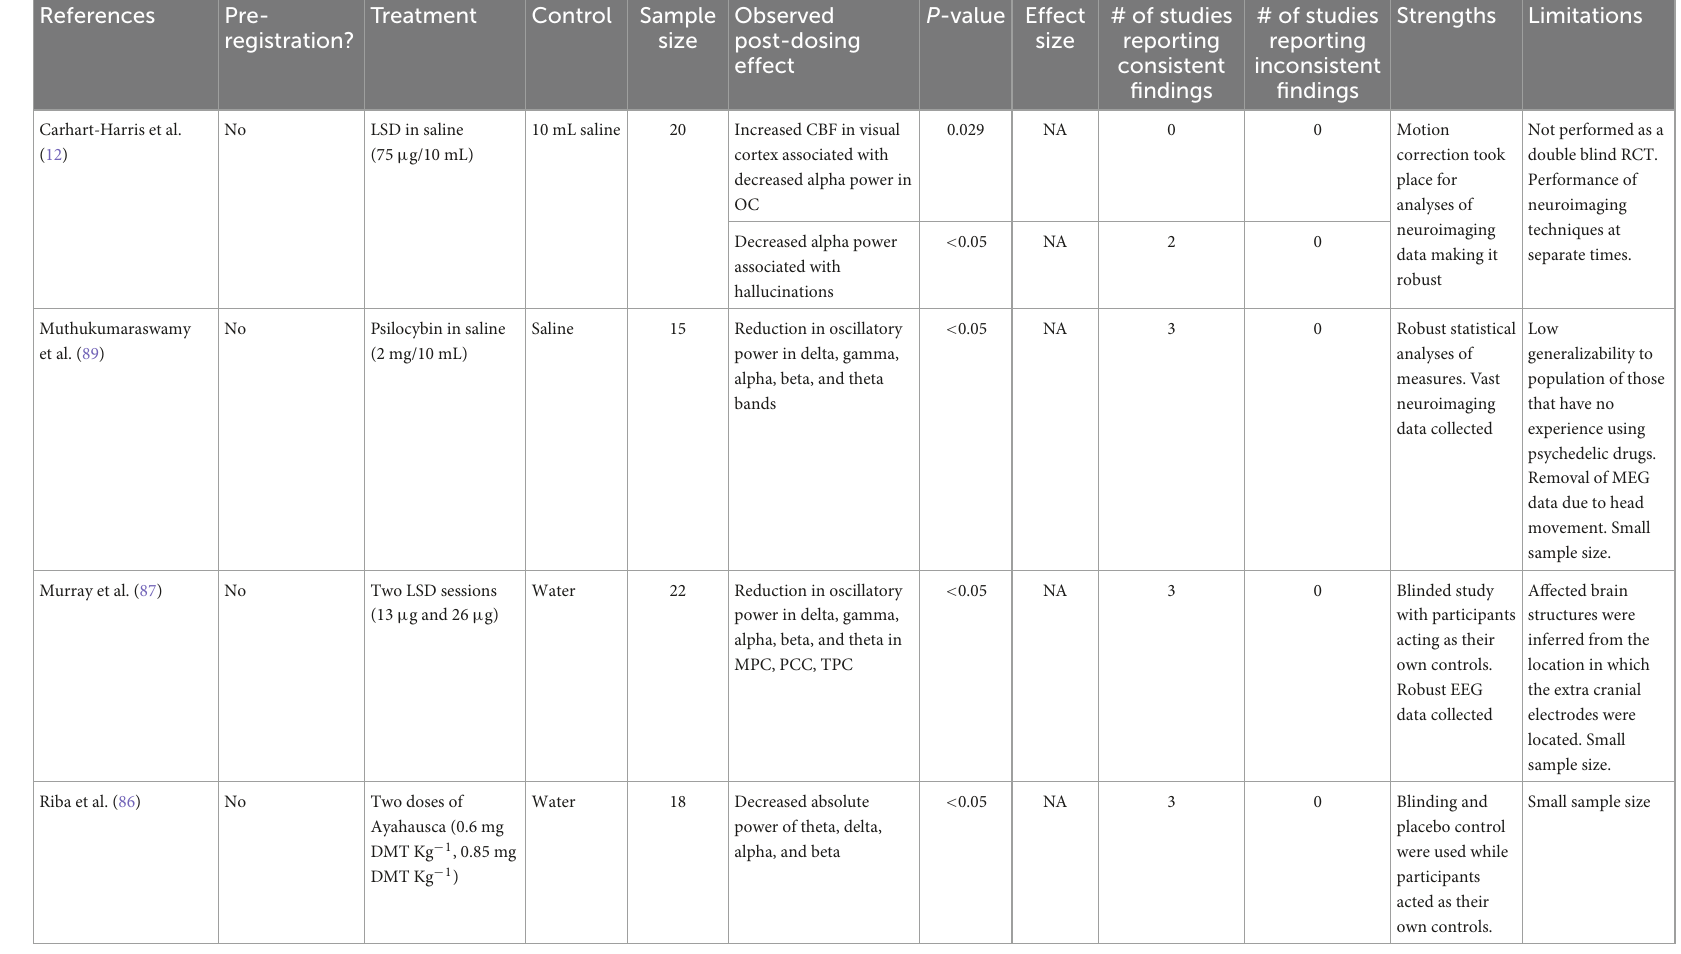
TABLE 2 Summary of neurophysiology